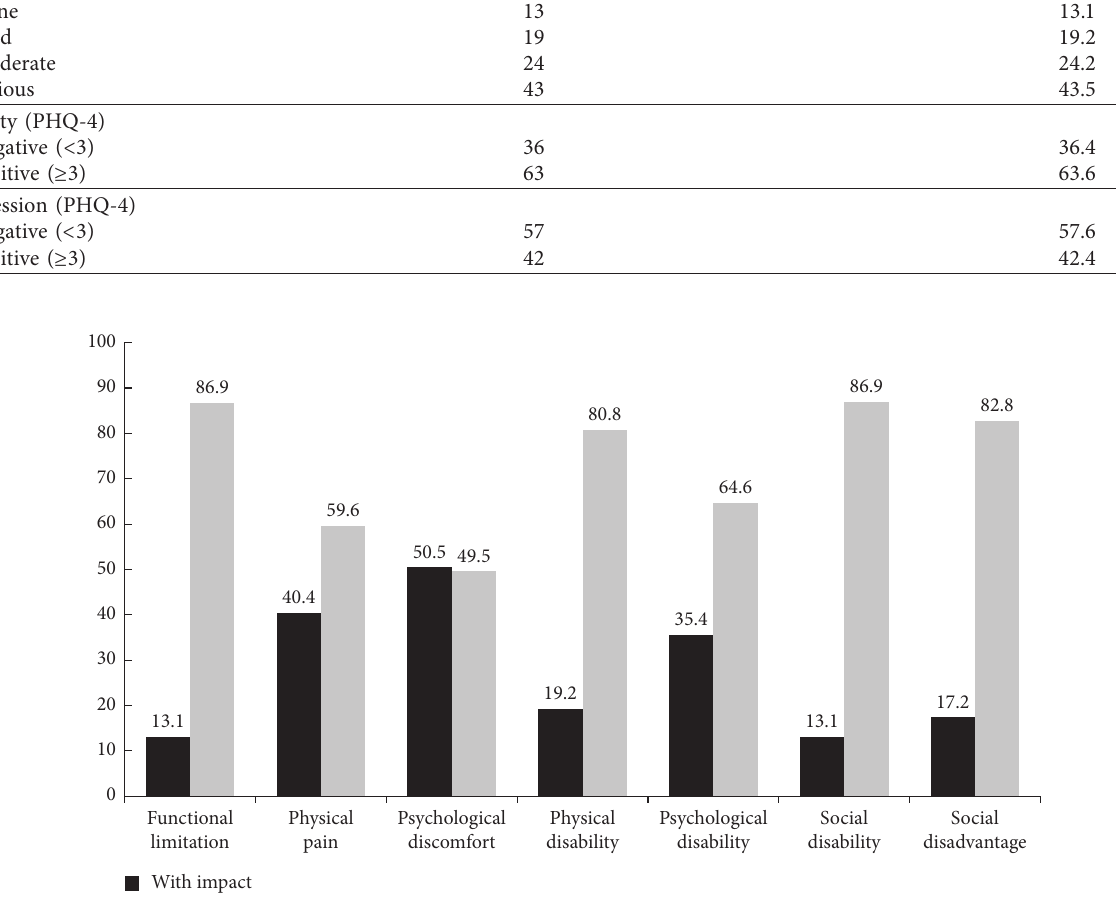
Figure 2: Distribution of women inmates in Juiz de Fora, according to the prevalence of impact, by OHIP-14 domains, Juiz de Fora,